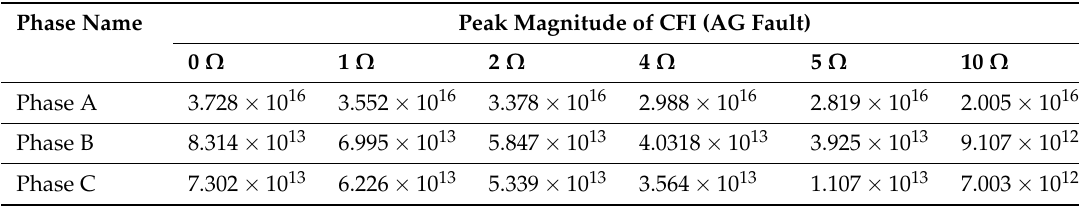
Table 2. Performance of Fault Recognition Algorithm with Variable Fault